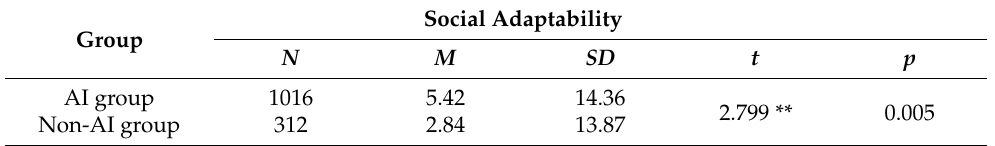
Table 4. Social adaptability of AI group and non-AI group.